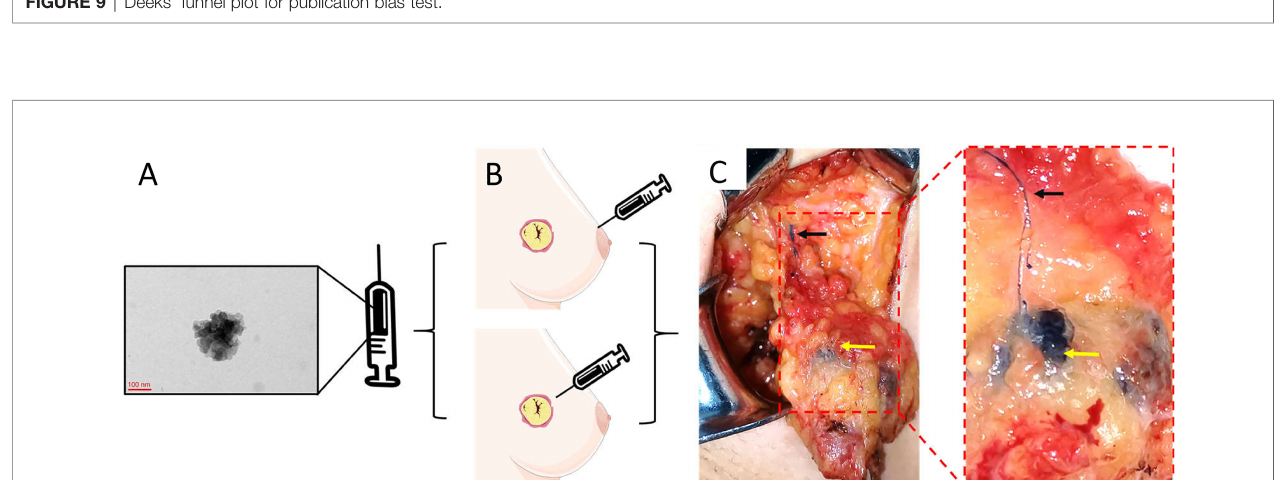
FIGURE 10 | The speci fi c operation steps of CNSs as lymphatic tracer in SLNB. (A) The morphology of CNSs; (B) Injection site of CNSs; (C) Color rendering of CNSs in SLNB (Black arrow: Lymphatic vessel; Yellow arrow: Lymph node). (A) is the image of CNSs under transmission electron microscopy. Republished with permission of SAGE Publications, Inc., from Liu X, Chang S, Jiang XL, Huang P, Yuan ZT. Identifying parathyroid glands with carbon nanoparticle suspension does not help protect parathyroid function in thyroid surgery: a prospective, randomized control clinical study. Surg Innov (2016) 23(4):381 – 9. doi: 10.1177/ 1553350615624787. © The Author(s) 2016; permission conveyed through Copyright Clearance Center, Inc